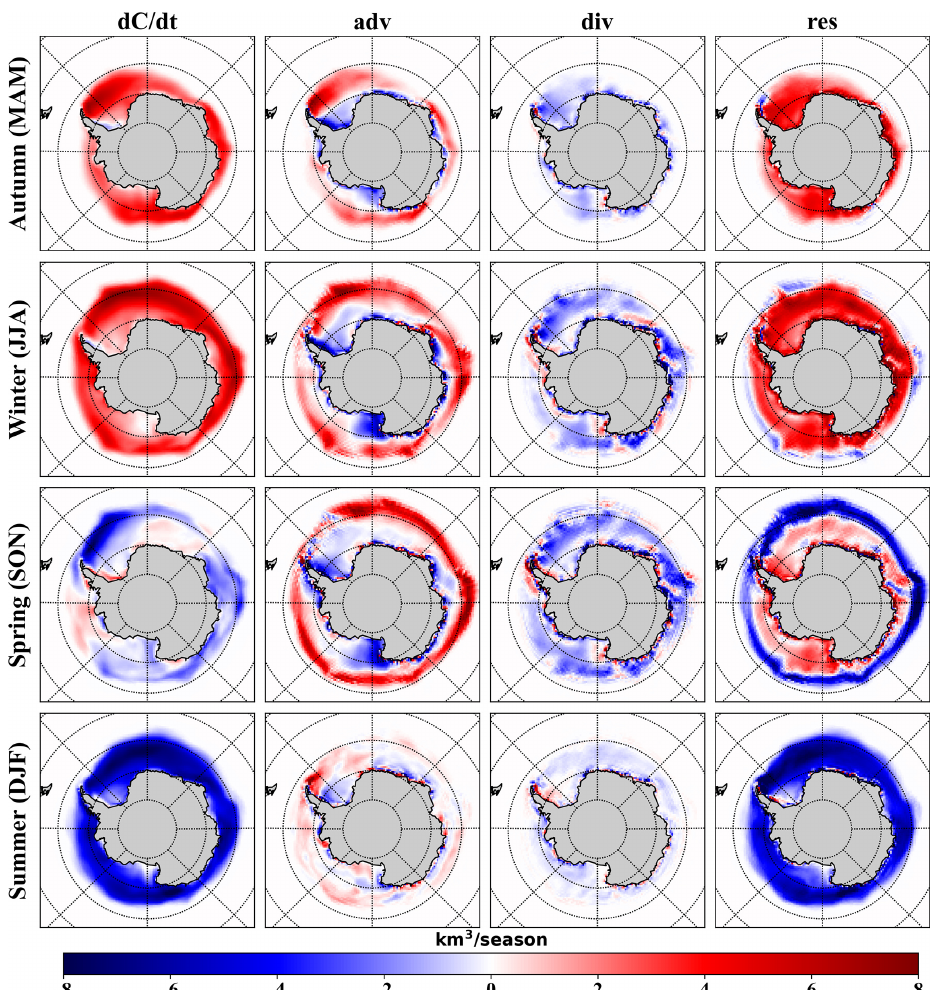
Figure 5. The same as Fig. 3 but for SIV budget. A positive or negative value indicates an increase or decrease in SIV, respectively.